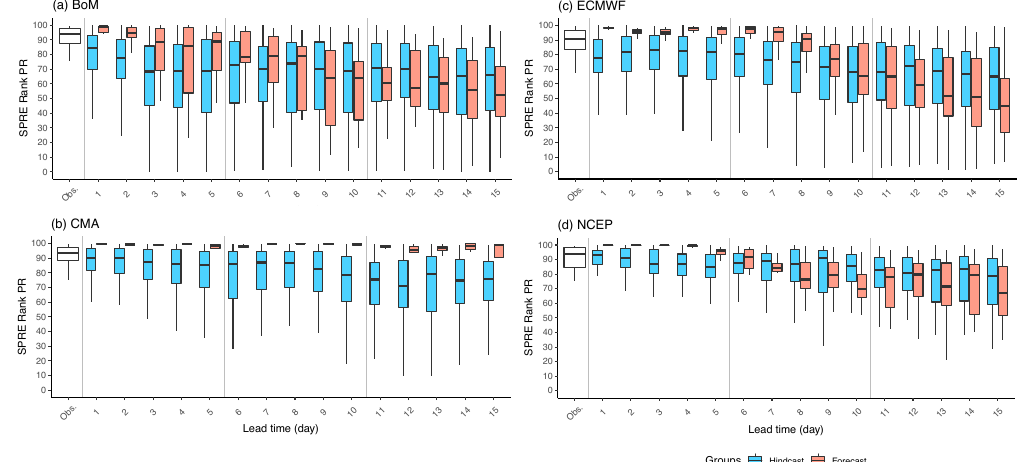
(a) BoM Figure 9. The percentile rank (PR) values of the SPRE rainfall amount of the hindcast SPREs (blue boxes) and 2018/19 SPRE (red boxes) with different lead times. The boxes are formed by multiyear and multimember data. The PR is ranked with all 15-day accumulated rainfall from December to February for 20 years (1998/99~2017/18). The hollow box in the far left for each plot is the PR ranges of historical SPREs based on CMORPH. Note that the observed PR value for the 2018/19 SPRE is 99, which is difficult to see in the plot. The results are simulated by ( a ) BoM, ( b ) CMA, ( c ) ECMWF, and ( d ) NCEP S2S forecast models. Outliers are estimated using Tukey [32] fences represented in